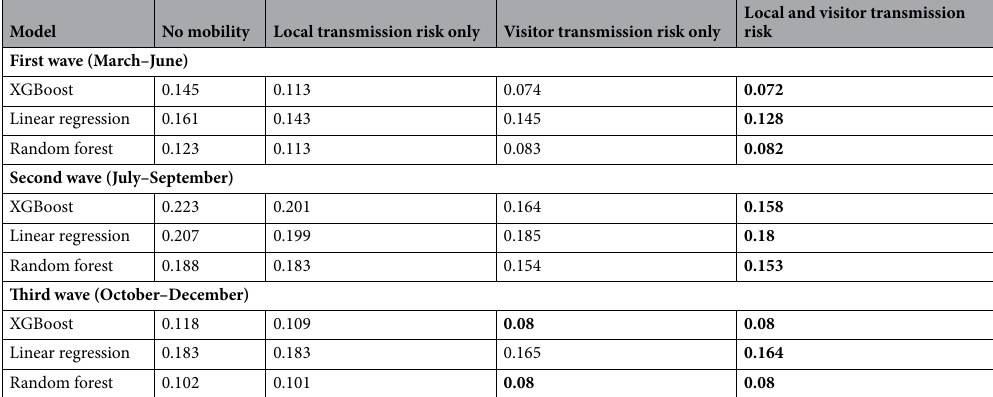
Table 4. Comparison of forecasting performance using RMSE with and without local and visitor transmission risk for three waves using various machine learning models. Best scenario for each machine learning approach is highlighted in [bold].